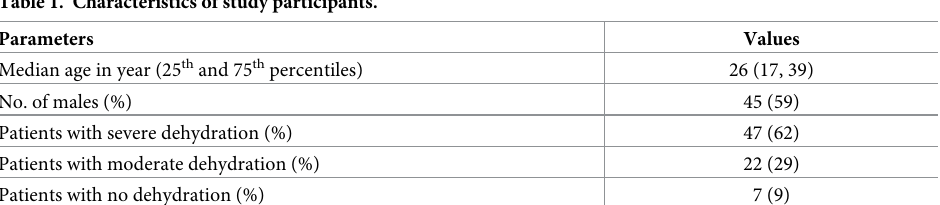
Table 1. Characteristics of study